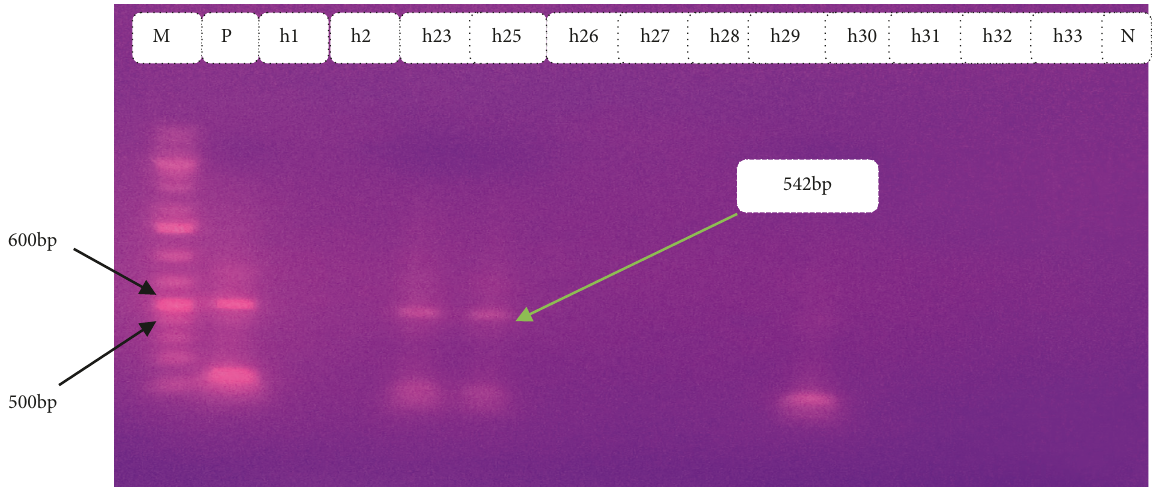
Figure 5: Amplification of dae gene in Escherichia coli isolates from diarrheic children: M marker (100bp DNA ladder) P positive control, lane no. h23, and h25 indicates positive samples, lane no. h1, h2, and h26–h33 indicates negative samples and N negative